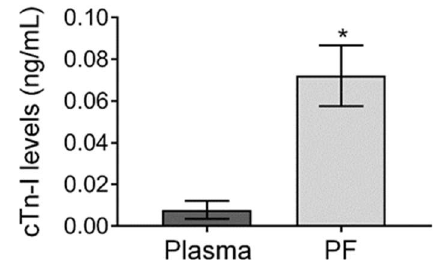
Figure 4. Data show that in CABG patients, compared to the plasma level, cTn-I level is significantly greater in the pericardial fluid (PF). Two-tailed independent t-test showed that cTn levels of PF were significantly higher than that of blood plasma (0.01 ± 0.004 vs. 0.07 ± 0.01 ng/mL, respec- tively, p < 0.05). PF—pericardial fluid, cTn-I—cardiac troponin-I. Data expressed as mean ±SEM. p < 0.05 was considered significant, which is indicated with an asterisk.